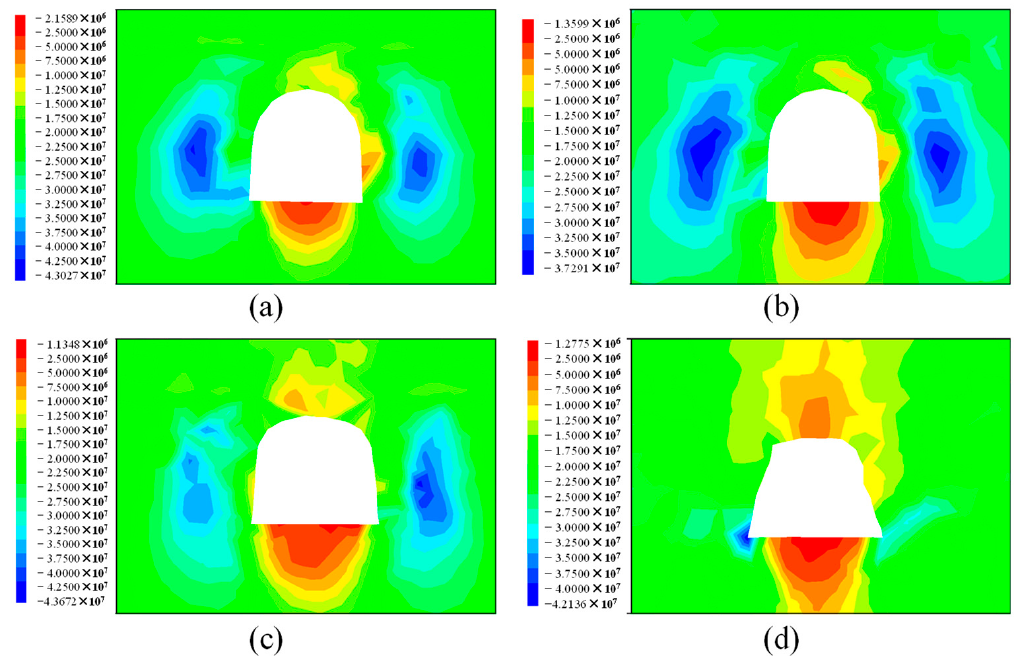
Figure 6. The distribution of vertical stress in the roadway: ( a ) Case 1; ( b ) Case 2; ( c ) Case 3; ( d ) Case 4.